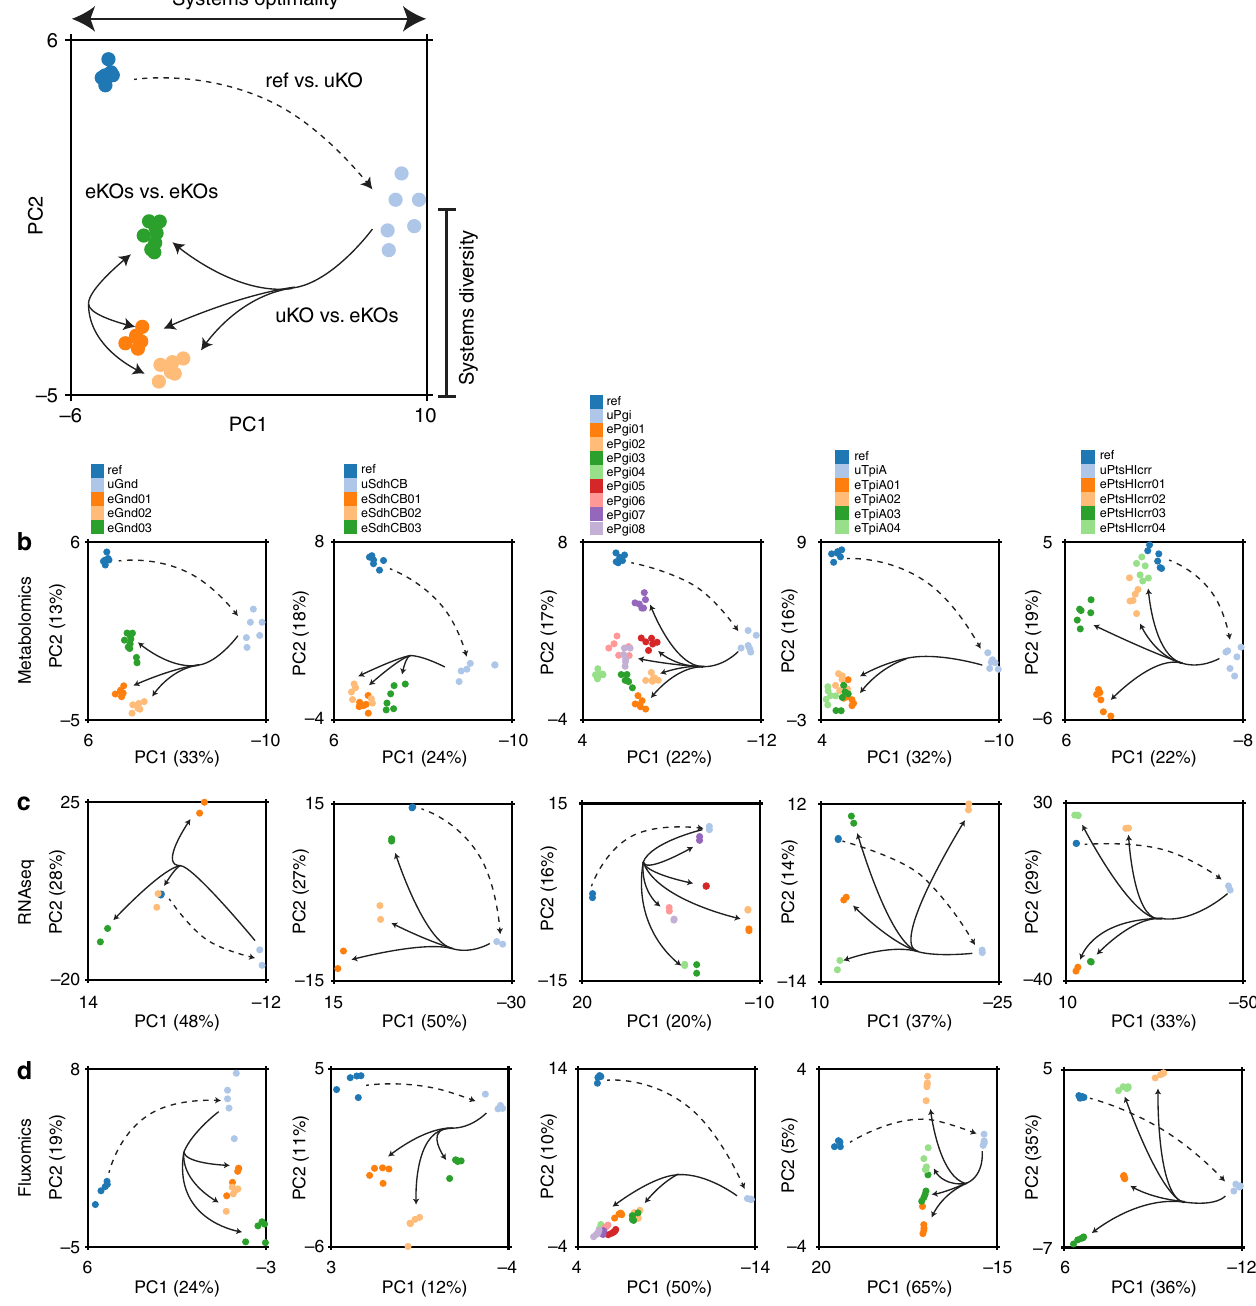
Fig. 2 A multivariate analysis of biological network components as represented by different omics data types. a Partial least squares discriminatory analysis (PLS-DA) revealed a common trend in the two most dominant components: the primary component (PC1) most often corresponded to a movement away from (dashed line) and back to (solid line) evolved optimal fi tness (i.e., optimal system con fi guration), while the secondary component (PC2) most often corresponded to a diversity among evolved optimal fi tness states of different lineages (i.e., optimal system con fi gurations). PLS-DA scores plots of the reference strain, initial knockout, and evolved endpoints for each lineage for metabolomics ( b ), transcriptomics ( c ), and fl uxomics ( d ) data. The strain lineages denoted on the top of b also refer to the corresponding graphs below in c and d . All of the KO lineages matched the trend described above in the metabolomics data, one eKO did not match the trend in four of the fi ve KO lineages in the expression data (i.e., all but eSdhCB), and one or more eKO did not match the trend in each of the KO lineages in the fl uxomics data (see Methods for